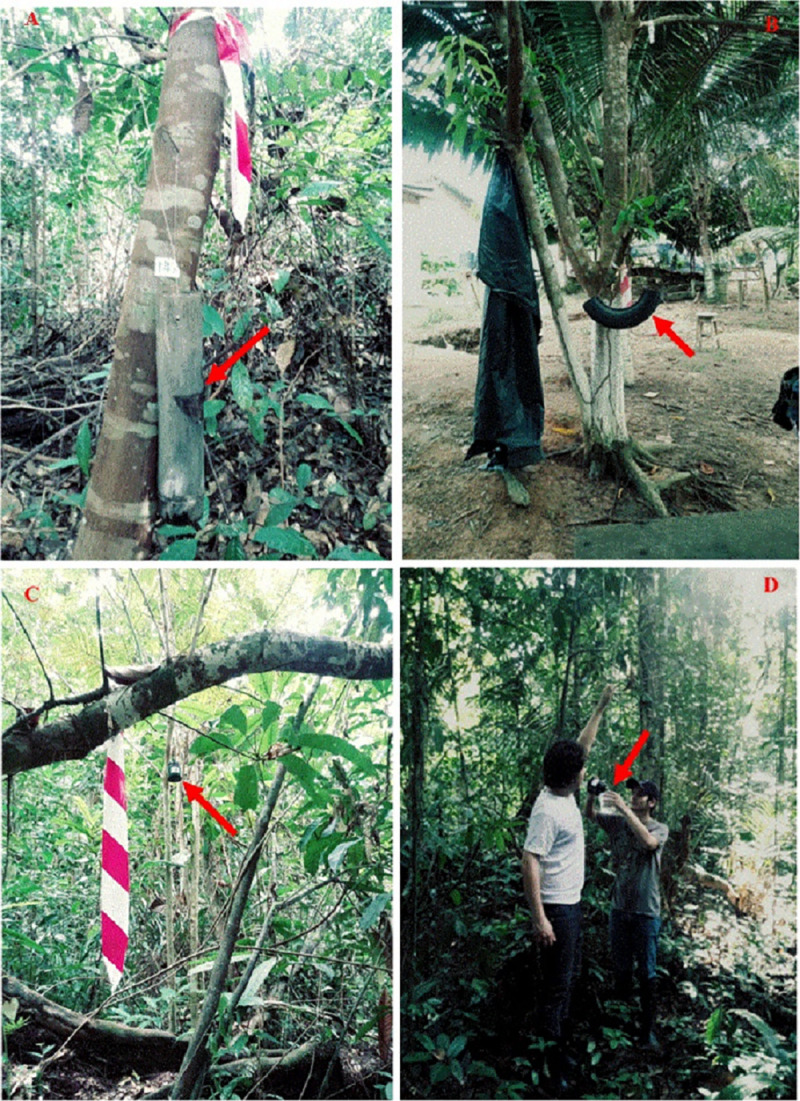
Larvitrap installations in the Rio Pardo agrovillage, Presidente Figueiredo, Amazonas, Brazil.A—bamboo internode. B—tire. C—plastic container. D—trap installation. The arrows point to the installed larvitraps for the collection of immature mosquitoes.